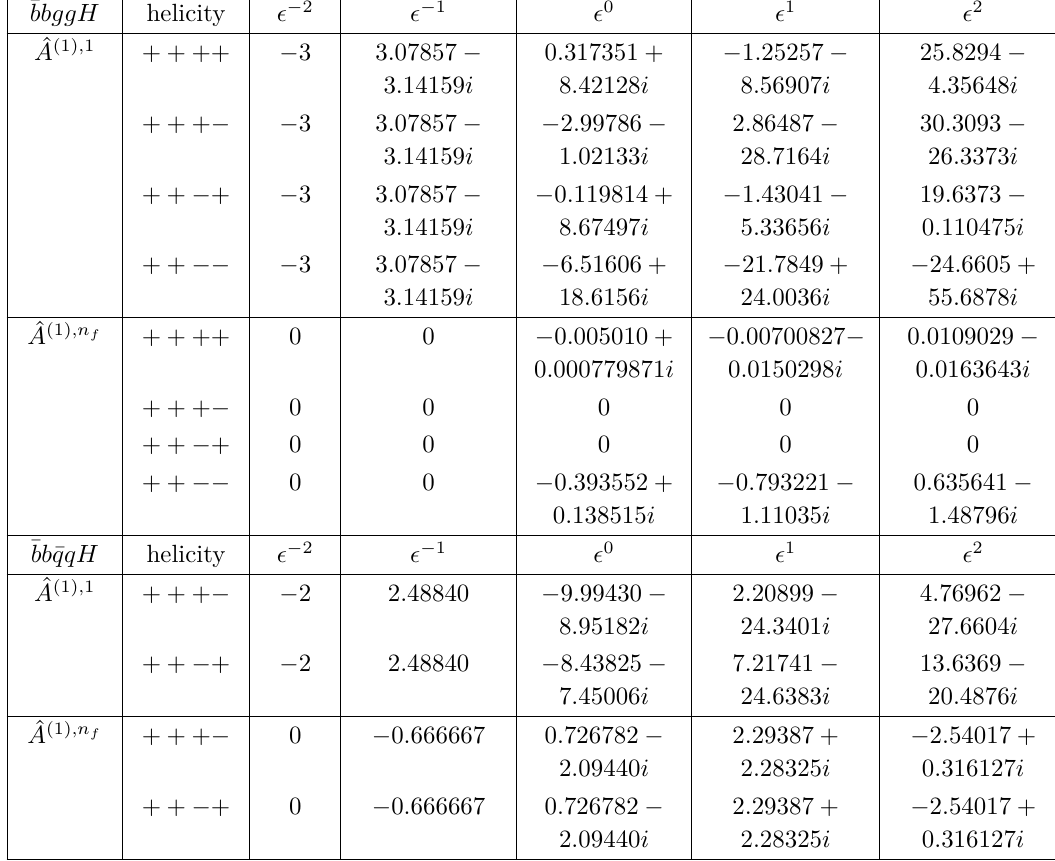
Table 6. Numerical values of the bare ¯ bbggH and ¯ bb ¯ qqH partial amplitudes at one loop (normalised to the tree-level amplitude) at the kinematic point in eq. (6.11) for the four independent helicity configurations and the various closed fermion loops